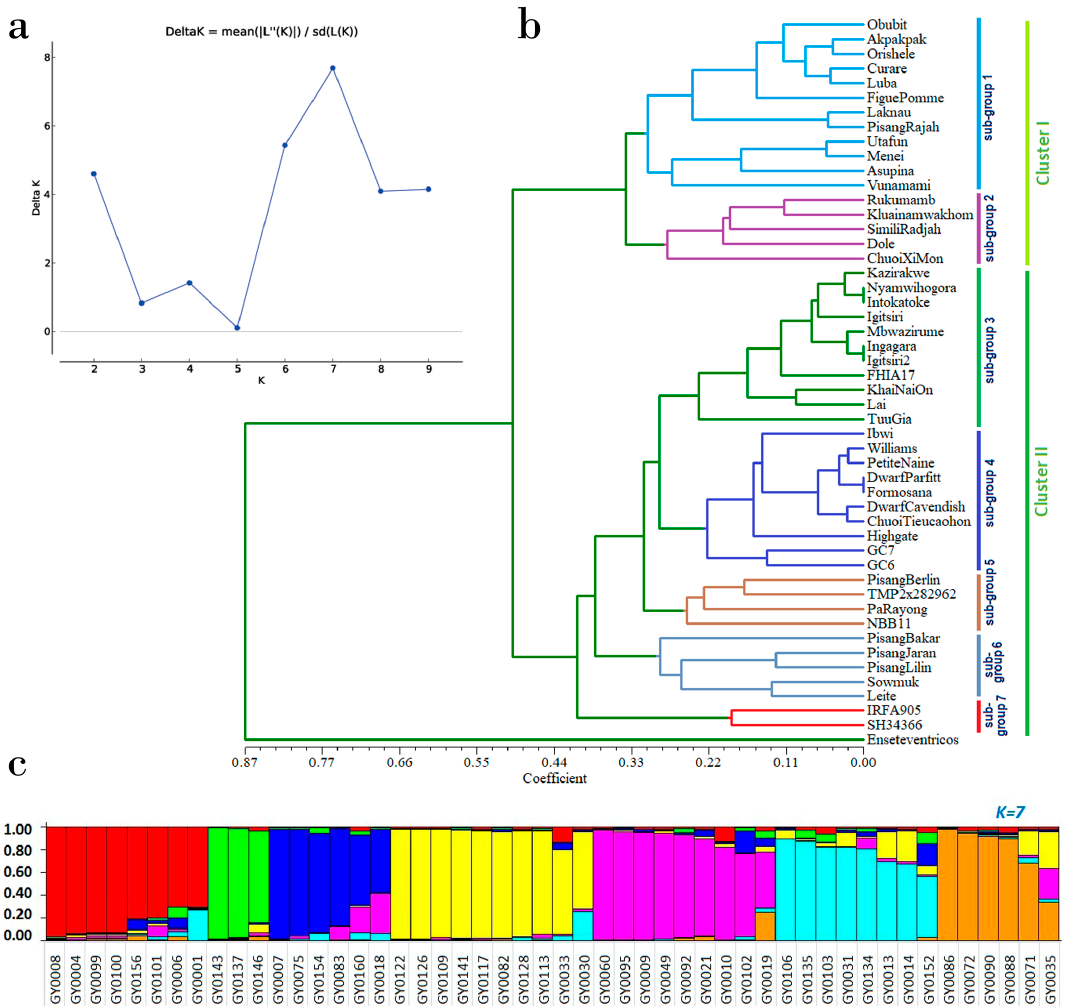
Figure 4. Phylogenetic relationship and population structure of 50 Musa accessions using 15 FRSMs; ( a ) plot of delta K values for different numbers of population assumed; ( b ) UPGMA dendrograms constructed based on the NEI72 similarity matrix; ( c ) sub-populations represented by distinct colours. Each column represents each accession (the name of the accession are presented in Table S15) that can be fractionated into segments, and the whole size has the potential to estimate membership fractions (q) in k clusters. The genomic background of each accession was based on morphological descriptions recorded in the Musa germplasm database.